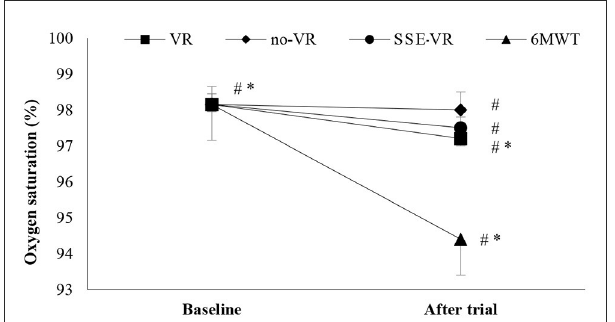
FIGURE3 Oxygen saturation changes between trials. * p < 0.001, # p < 0.05 [virtual reality (VR), exercise using the virtual reality system; no-VR, exercise without using the VR system; SSE-VR, self-selected exercise using the VR system; 6MWT, 6-min walk test].